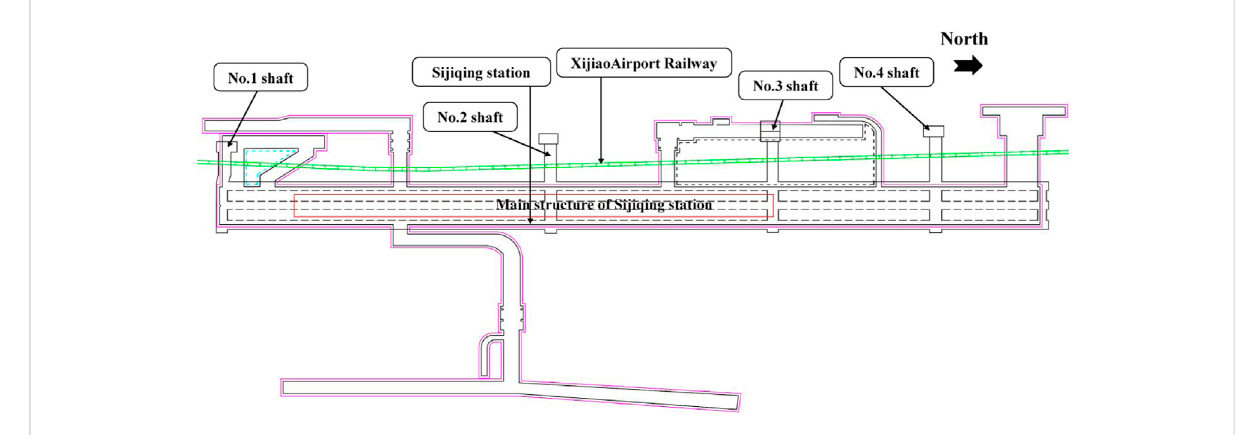
FIGURE 1 Plane sketch map of Sijiqing Station.